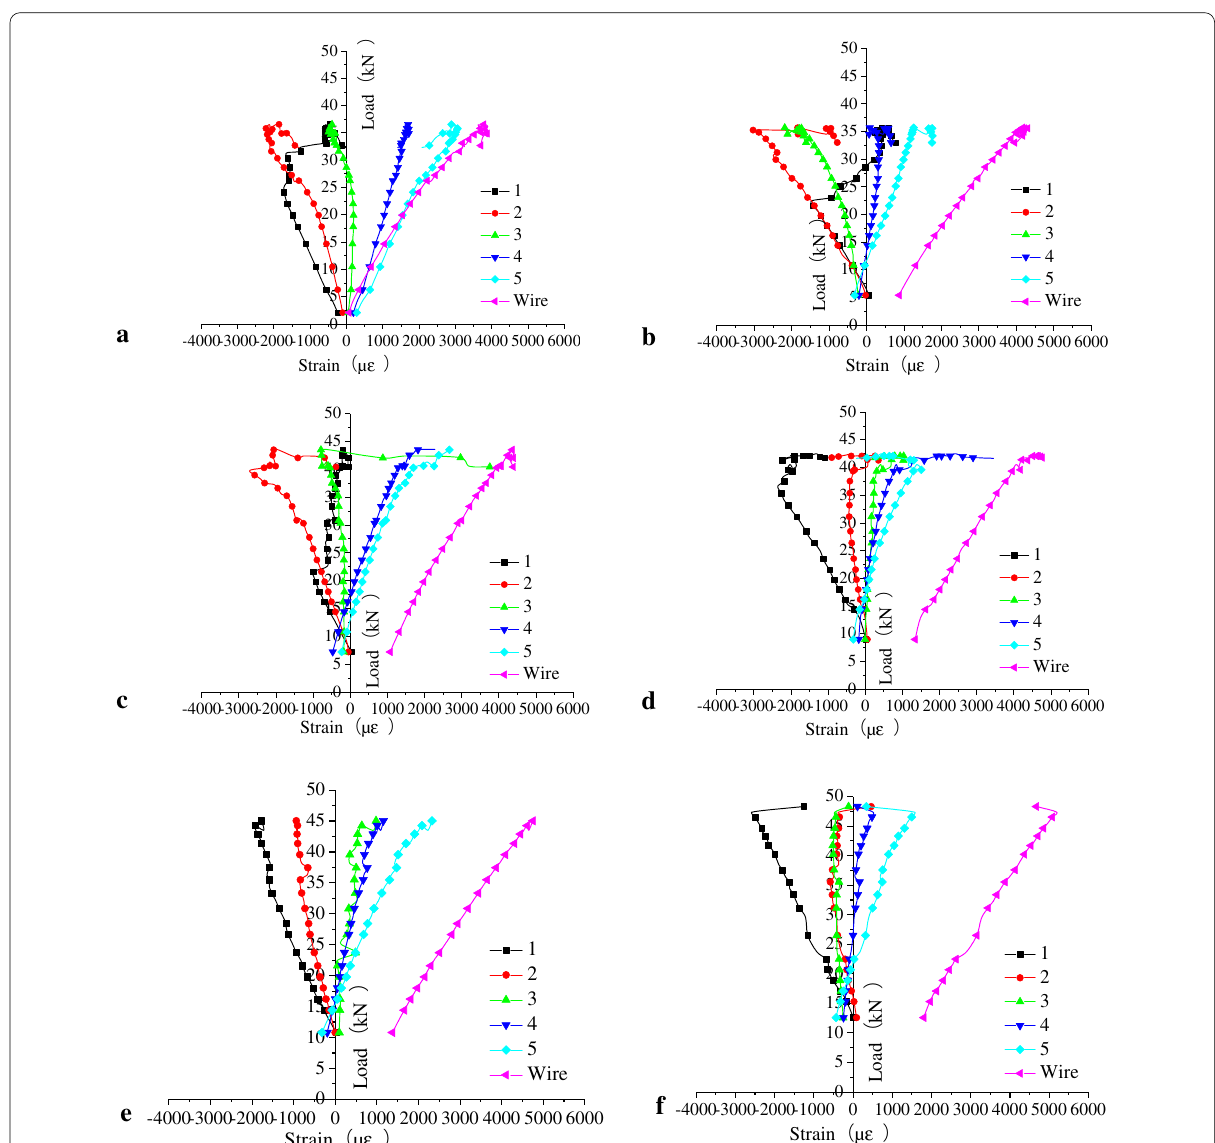
Fig. 13 Load–strain curves of all the specimens. a Control 0%; b Control 18%; c Control 24%; d Control 30%; e Control 36%; f Control